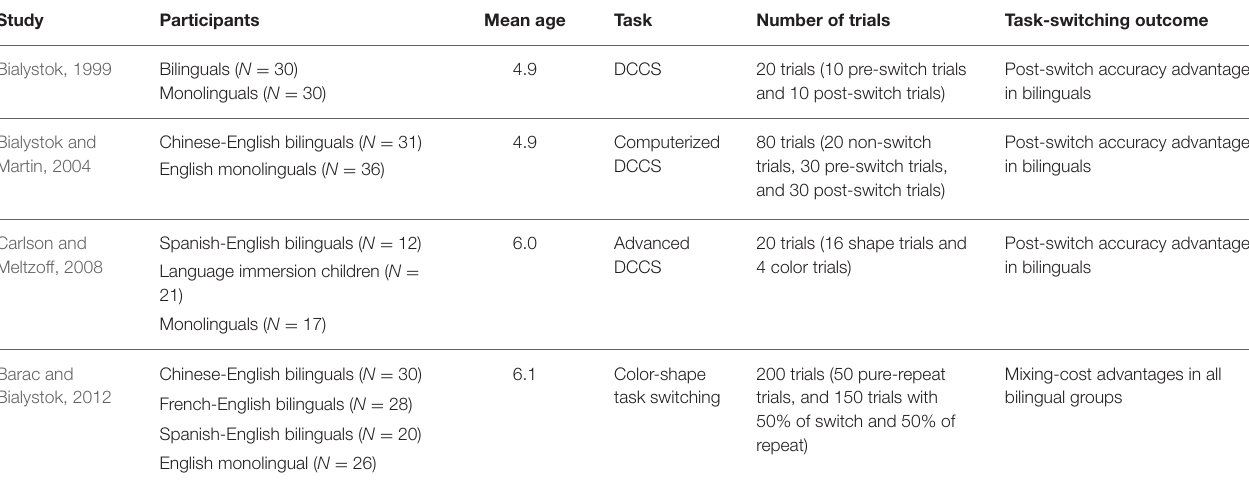
TABLE 2 | Summary of studies examining bilingual advantages in task-switching among young